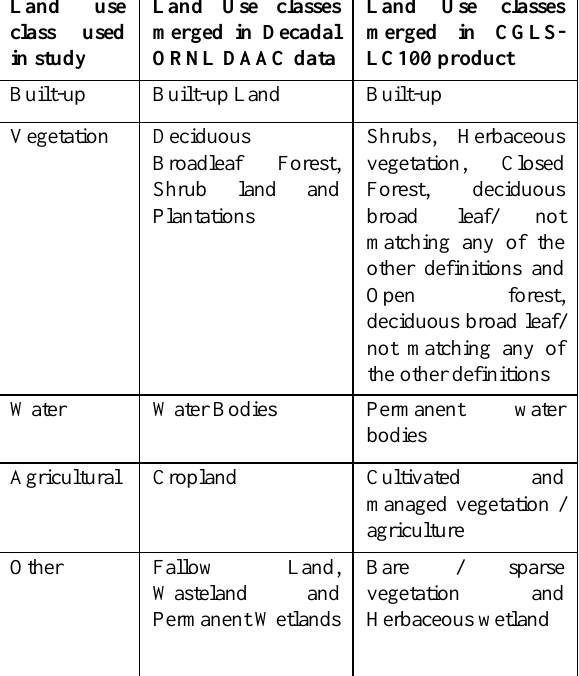
Table 1. Land use classes reclassified in the study.